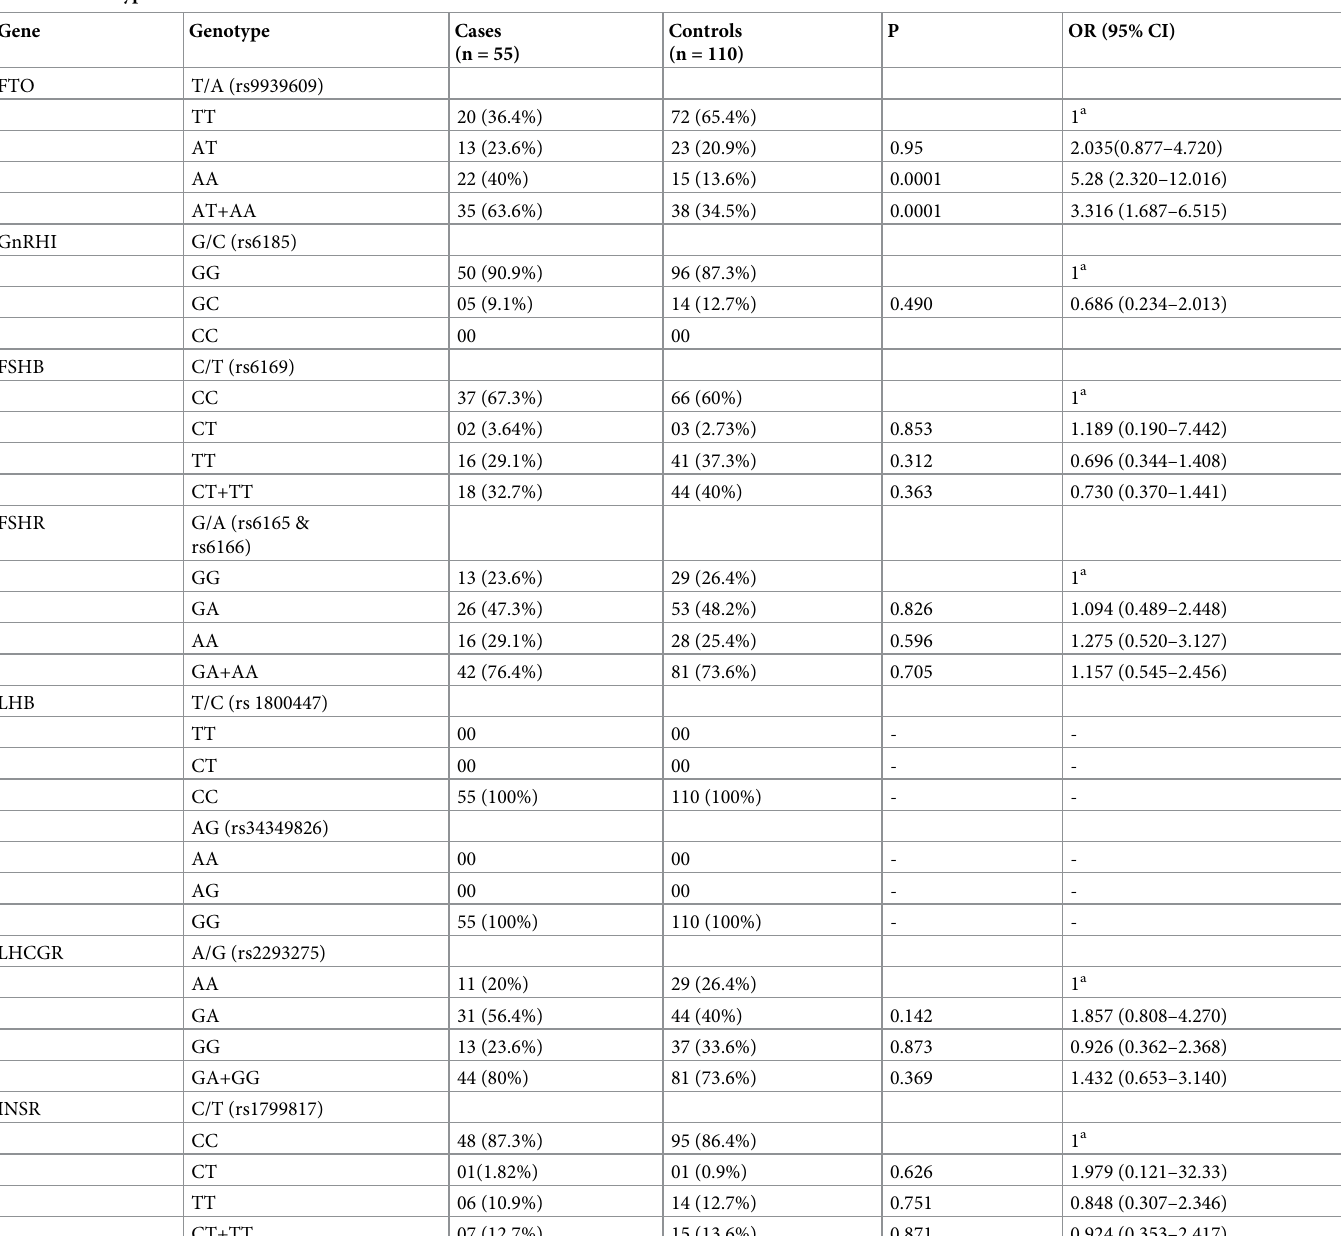
Table 3. Genotypes distribution in cases and